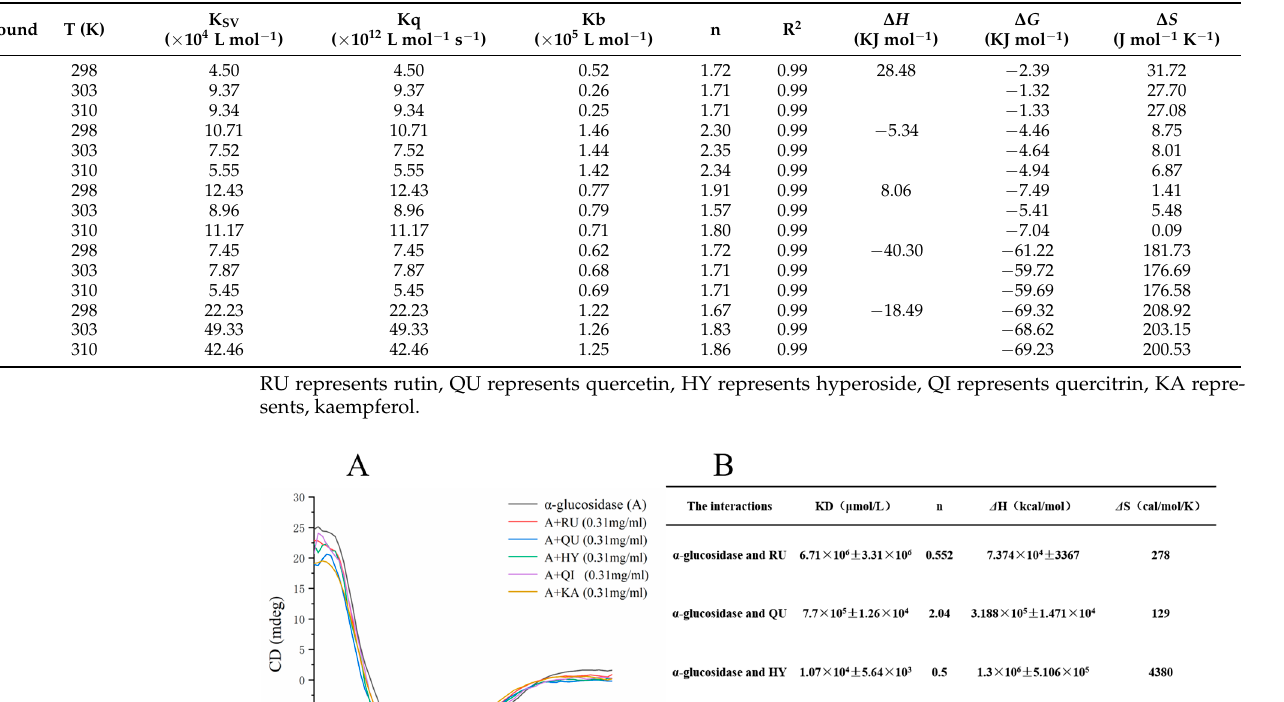
Table 4. Effect of RU, QU, HY, QI, KA on the binding constants, binding sites and thermodynamic parameters at 298, 303 and 310 K.